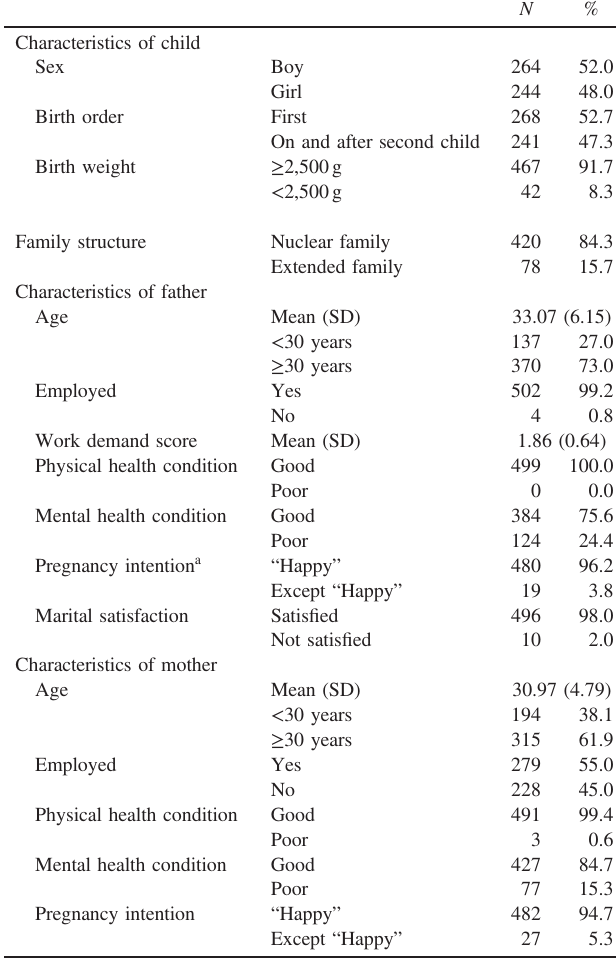
Table 1. Basic characteristics of participants ( N = 509)